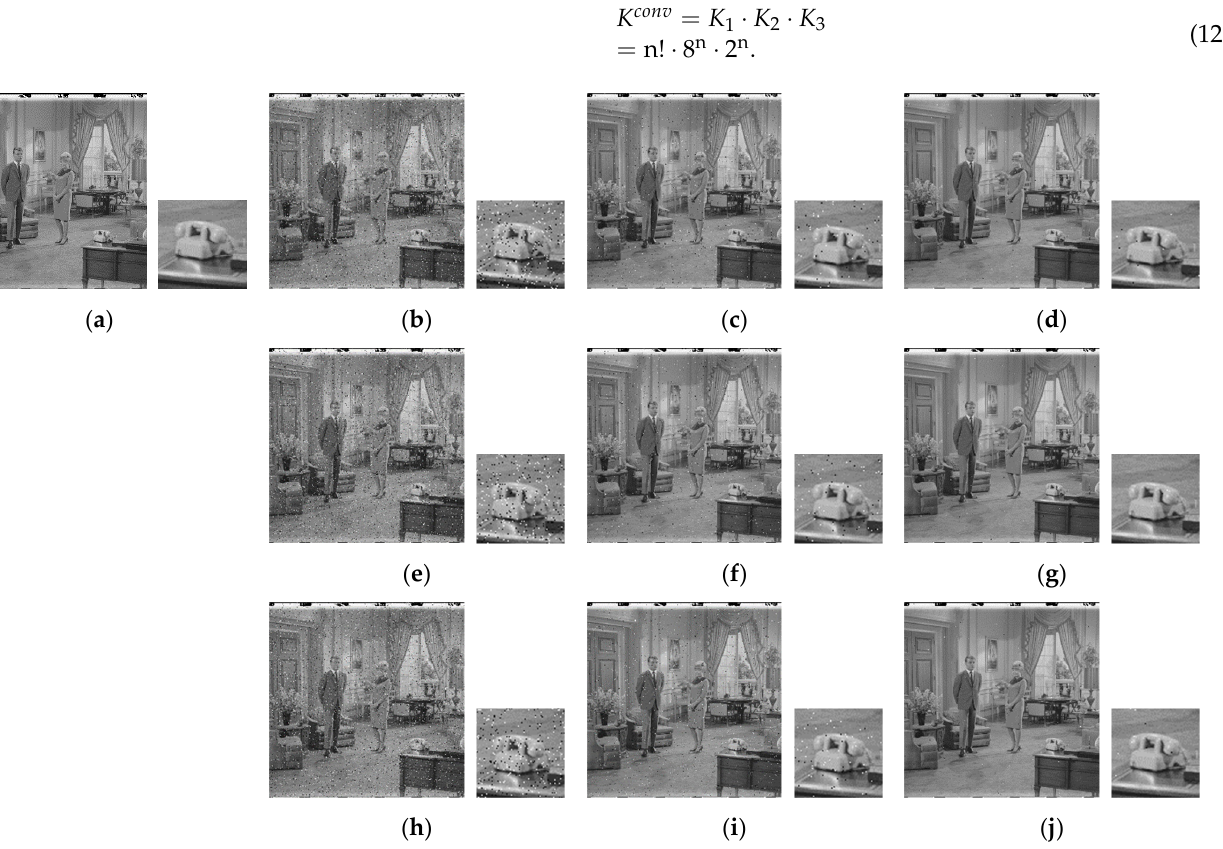
Figure 5. Robustness analysis of perceptual encryption (PE) methods against Salt and Pepper noise (SPN). ( a ) is original image without noise. Recovered images from noisy cipher images by conventional PE method ( b – d ), proposed PE method (4 × 4) ( e – g ) and proposed PE method (2 × 2) ( h – j ). The SPN intensity is { 0.05, 0.0125, 0.001 } in Column 2–4, respectively. The telephone set is zoomed in every image and is shown beside